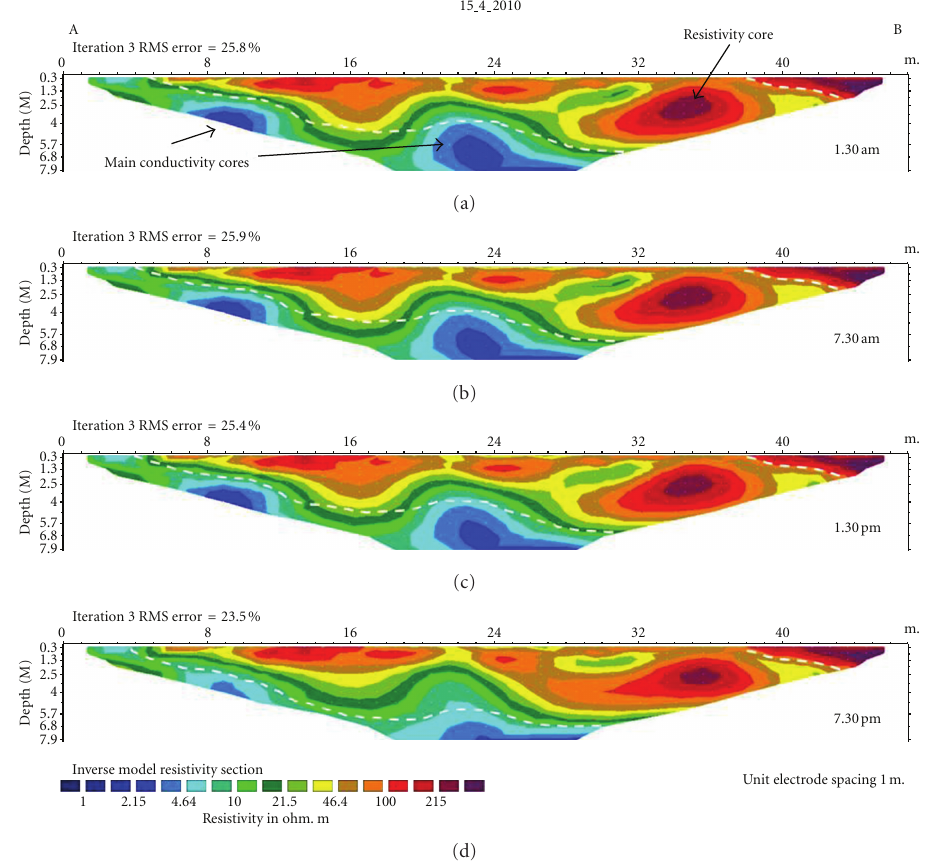
Figure 8: ERT related to the 15/04/2010 daily cycle of